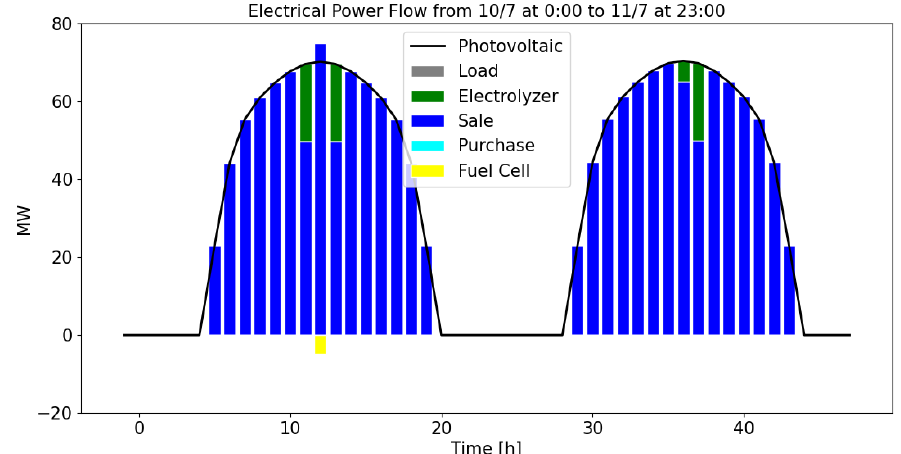
Figure 10. Hourly diagram of electrical power produced by PV, sold to the grid and used to supply electrolyser and local